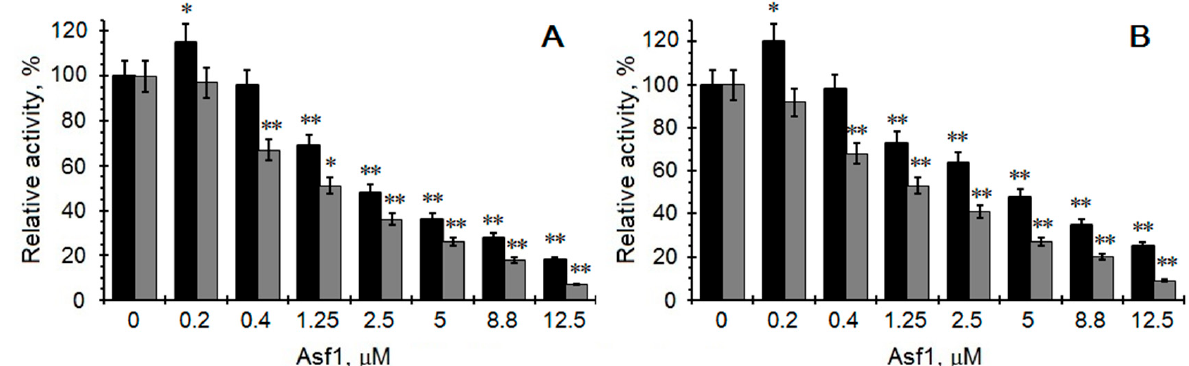
Figure 2. Effect of different Asf1 concentrations on kinase activity of CK2 α (black bars) and CK2 α ’ (grey bars) from human ( A ) and yeast ( B ). The reaction was carried out using yeast P2B (10 µ M) as a substrate and 20 µ M ATP. Relative activities are calculated towards enzyme activity in the absence of Asf1. * and ** indicate significant difference compared to the controls ( p < 0.05, p < 0.01).